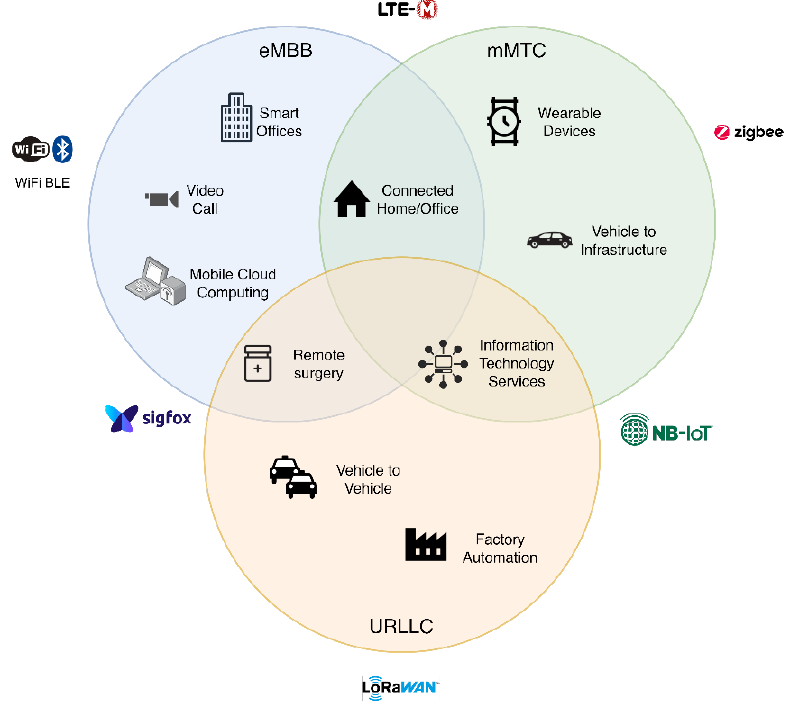
Figure 1. 5G Smart Application use-cases